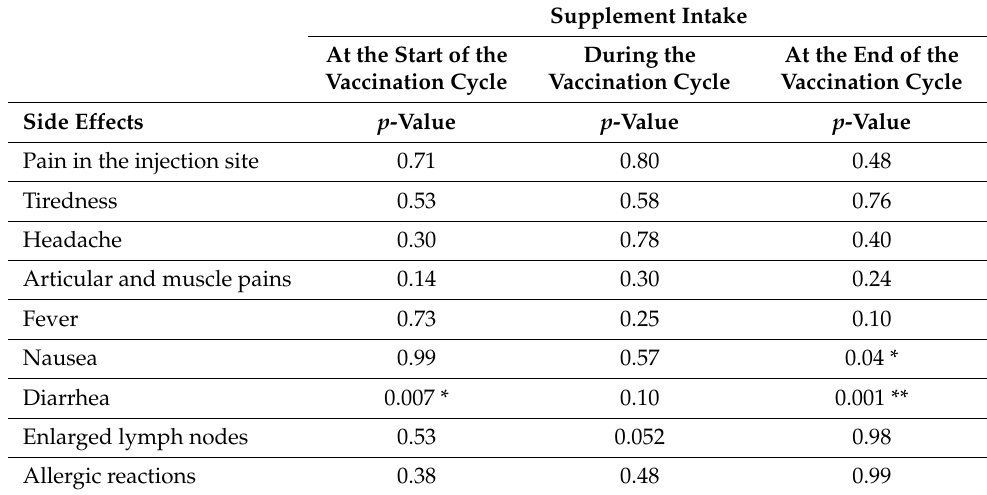
Table 6. Association between supplement intake and individual vaccination side effects, at the start, during, and at the end of the vaccination